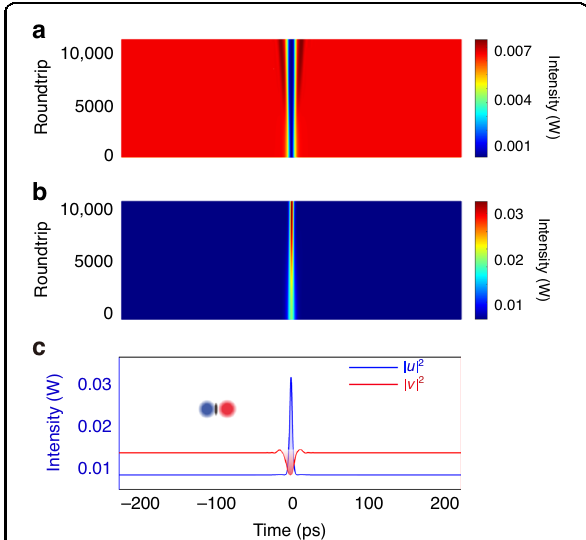
Fig. 9 A typical ODBS state numerically simulated. More details can be found in Section 4 in Supplementary Material. Parameters used in the simulation: A ¼ 0 : 1 ; B ¼ 1 ; β